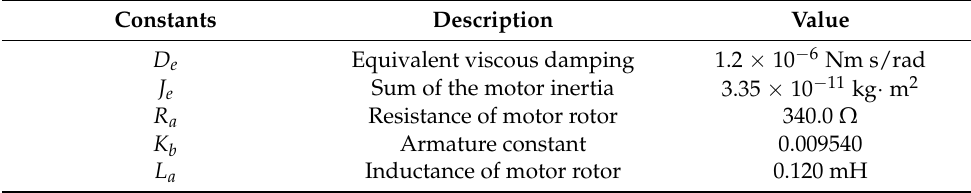
Table 1. Specification for DC